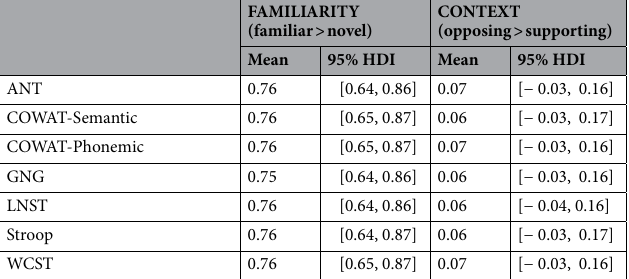
Table 2. Posterior means and 95% HDIs of drift rates in each factor (FAMILIARITY and CONTEXT) with regard to seven neuropsychological test performances. ANT attention network test, COWAT controlled oral word association test, GNG go/no-go, LNST letter number sequencing task, WCST Wisconsin card sorting test, HDI highest density interval.